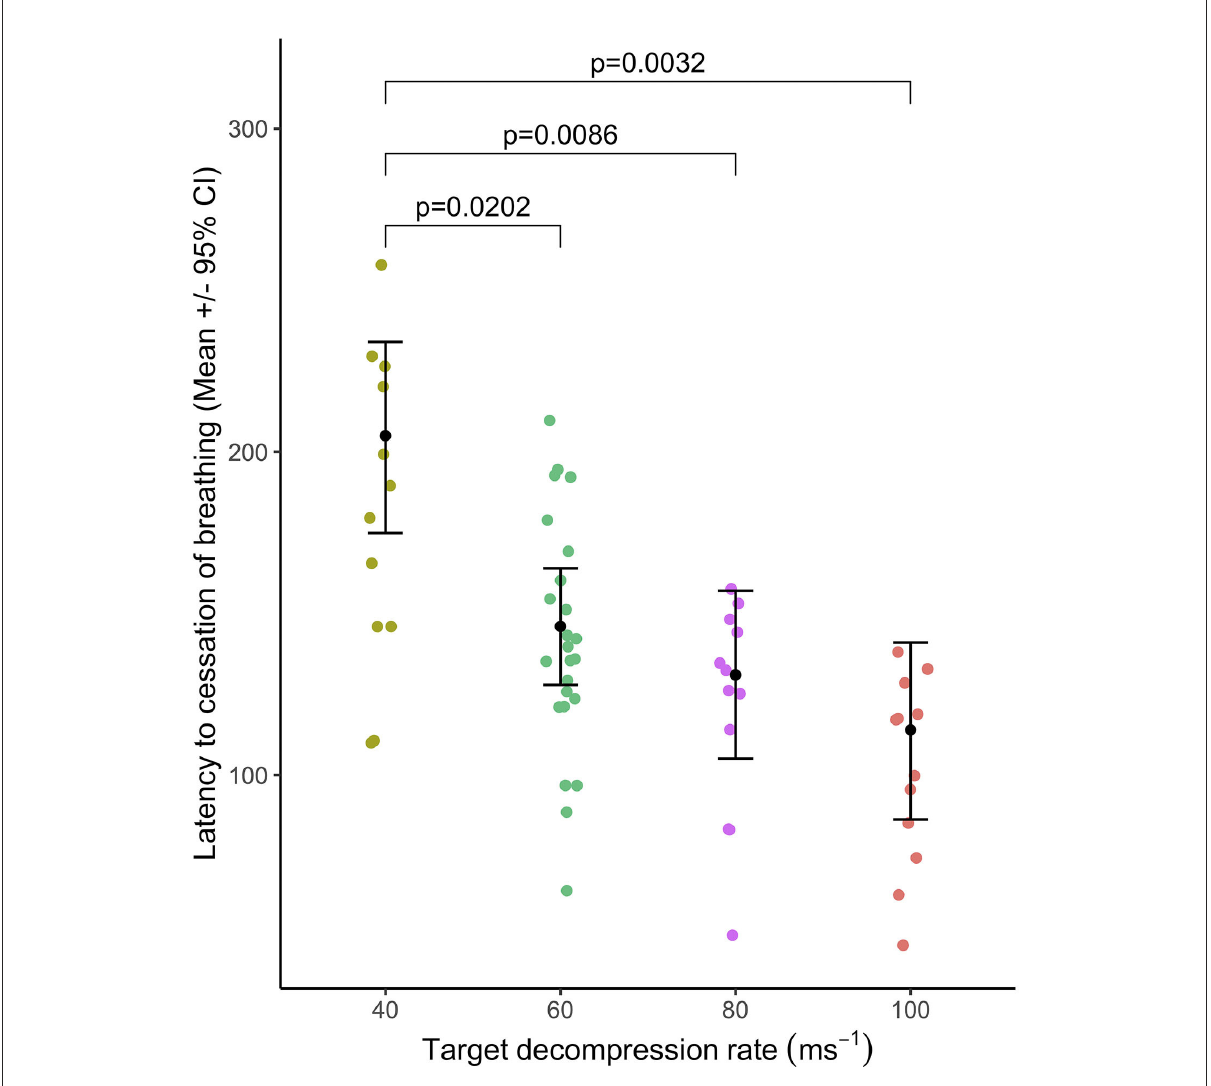
FIGURE8 Mean ( ± 95% CIs) latency to cessation of breathing relative to target decompression cycle rates: 40 ms − 1 ( n = 12), 60 ms − 1 ( n = 24), 80 ms − 1 ( n = 12), or 100 ms − 1 ( n = 12). Only significant pairwise comparisons are